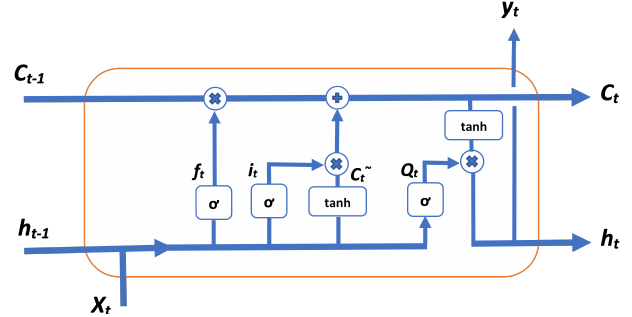
Figure 1. One Long Short-Term Memory (LSTM) block